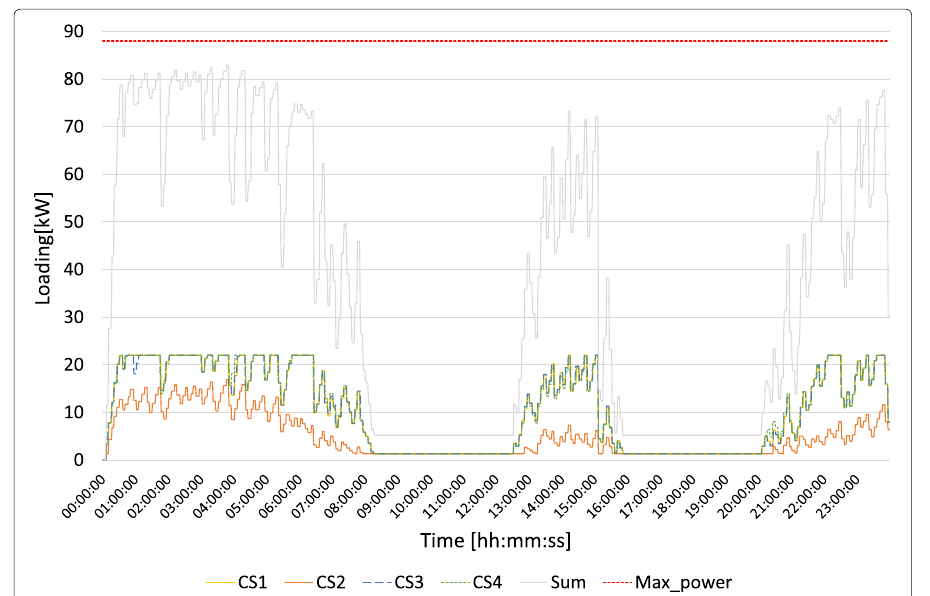
Fig. 10 Power of charging stations. The colored lines represent the power of each single charging station and the gray line depicts the sum of their charging power. The dotted red line shows the rated maximum power of all four charging station